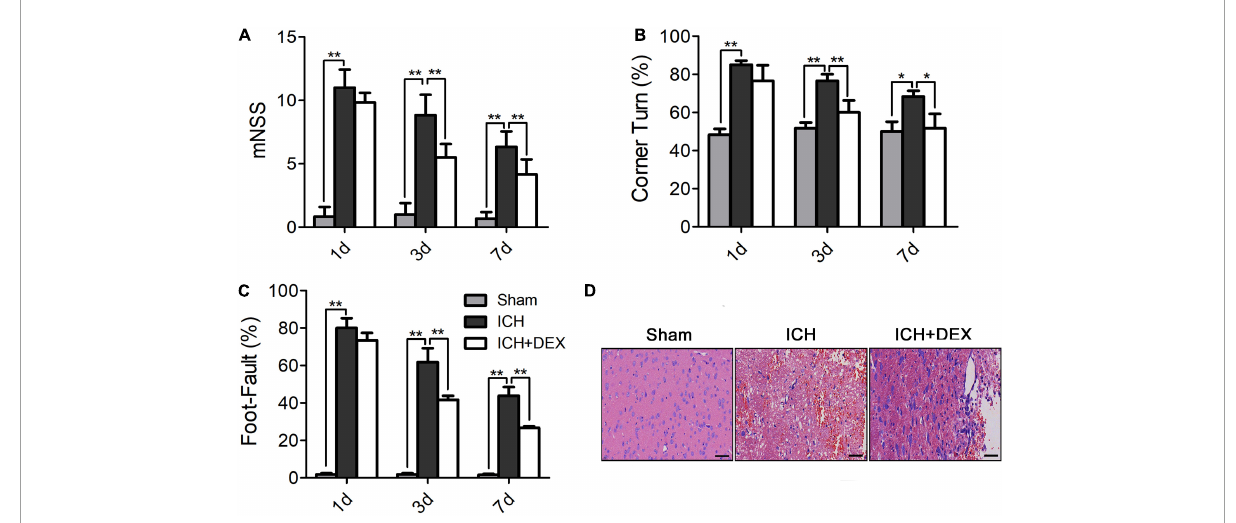
FIGURE1 (A) The DEX markedly ameliorated total neurological deficit scores and improved neurological functions compared to the ICH group (a decrease in the mNSS) on days 3 and 7 after ICH. Additionally, the DEX-treated rat significantly outperformed the ICH rat in the corner turn test (B) and the foot-fault test (C) (on day3 and 7). (D) On the 3rd day post-ICH, the neuronal necrosis and degeneration in the DEX-treated group were less serious than in the ICH group. Scale bar = 50 µ m. Values are expressed as mean ± SD. * p < 0.05, ** p <